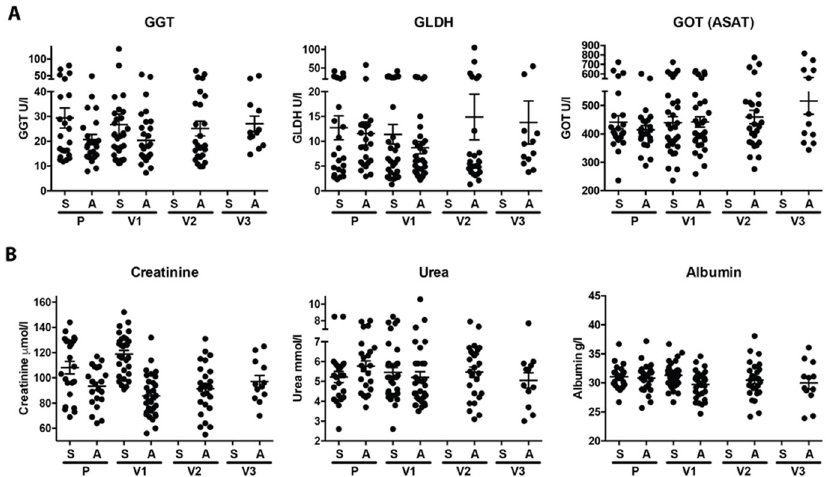
Figure 4. Immune complex disease by liver and kidney parameters. Liver ( A ) and kidney ( B ) parameters were measured in spring (S) and autumn (A) in the placebo year and the 1st (V1), 2nd (V2), and 3rd (V3) treatment year. Values of the individual horses are shown with mean and SEM. Statistical analysis was performed by Kruskal–Wallis with Dunn’s multiple comparison. Statistical significance is only indicated when at least one value was outside of the norm.